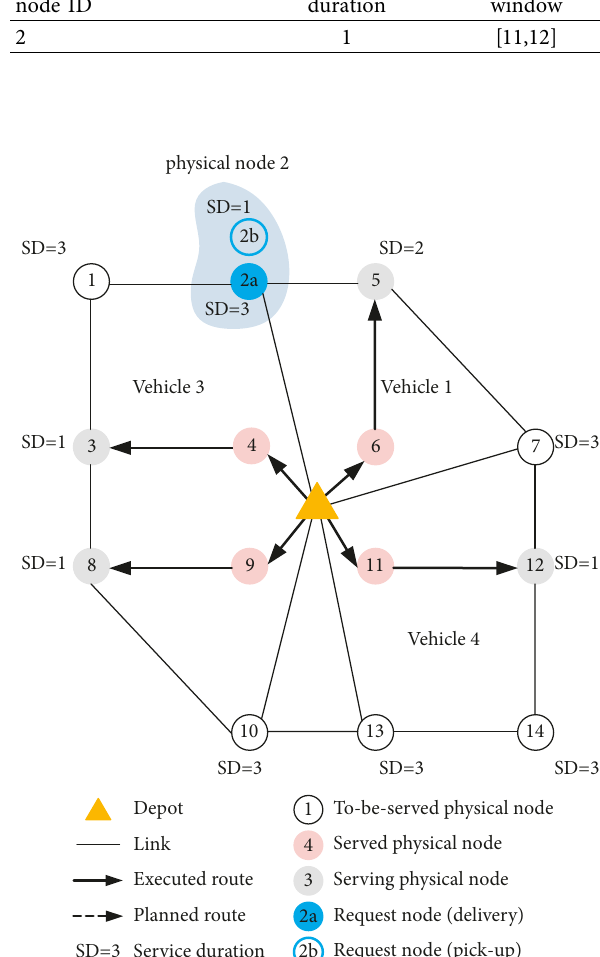
Figure 10: Updated physical network when τ �